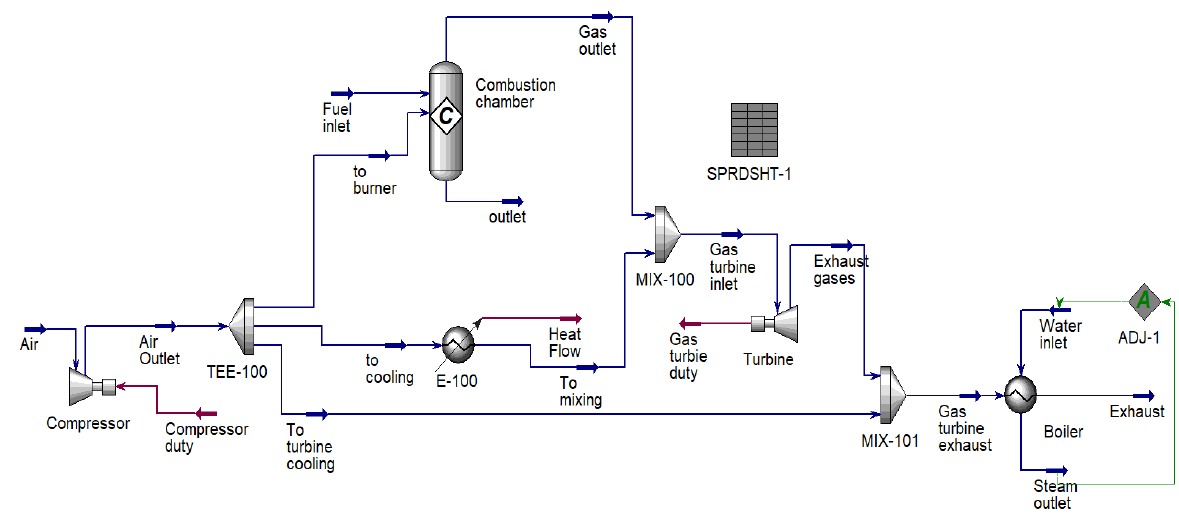
Figure 5. Diagram with a